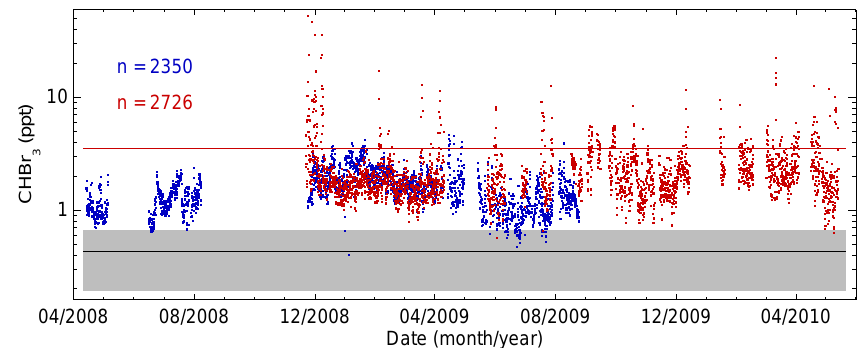
Fig. 1. Observations of CHBr 3 , averaged over 3 hour periods, from two locations in northern Borneo for April 2008 to May 2010. The blue data are from Bukit Atur, a rainforest location, and the red data are from Tawau, a coastal site. The y-axis is logarithmic. The solid black line marks the ‘baseline’ mixing ratio of 0.43 ppt assumed in the majority of the inversion experiments (see Sect. 3.2 for details). The shaded grey region indicates one standard deviation ( ± 0.24 ppt) of the noise added to the observations (or equivalently the baseline, see Sect. 3.2.4). The solid red line, at 3.51 ppt, marks the 90 th percentile of the coastal observations. The number of 3 hour periods for which observations are available is noted to the top-left of the plot.